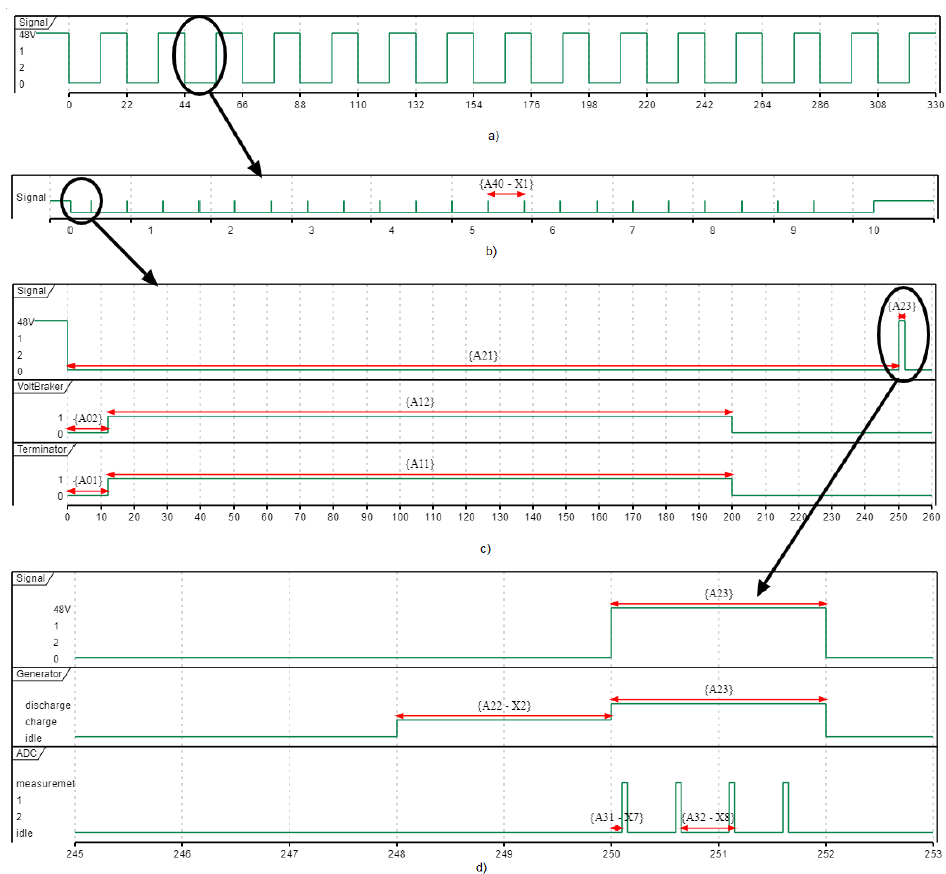
Figure 3. Auto-addressing signal. ( a ) Standard signal ( b ) Zoom to auto-addressing pulse ( c ) Zoom for preparationline to the first pulse ( d ) Zoom to pulse generation and sampling the answer on the line.